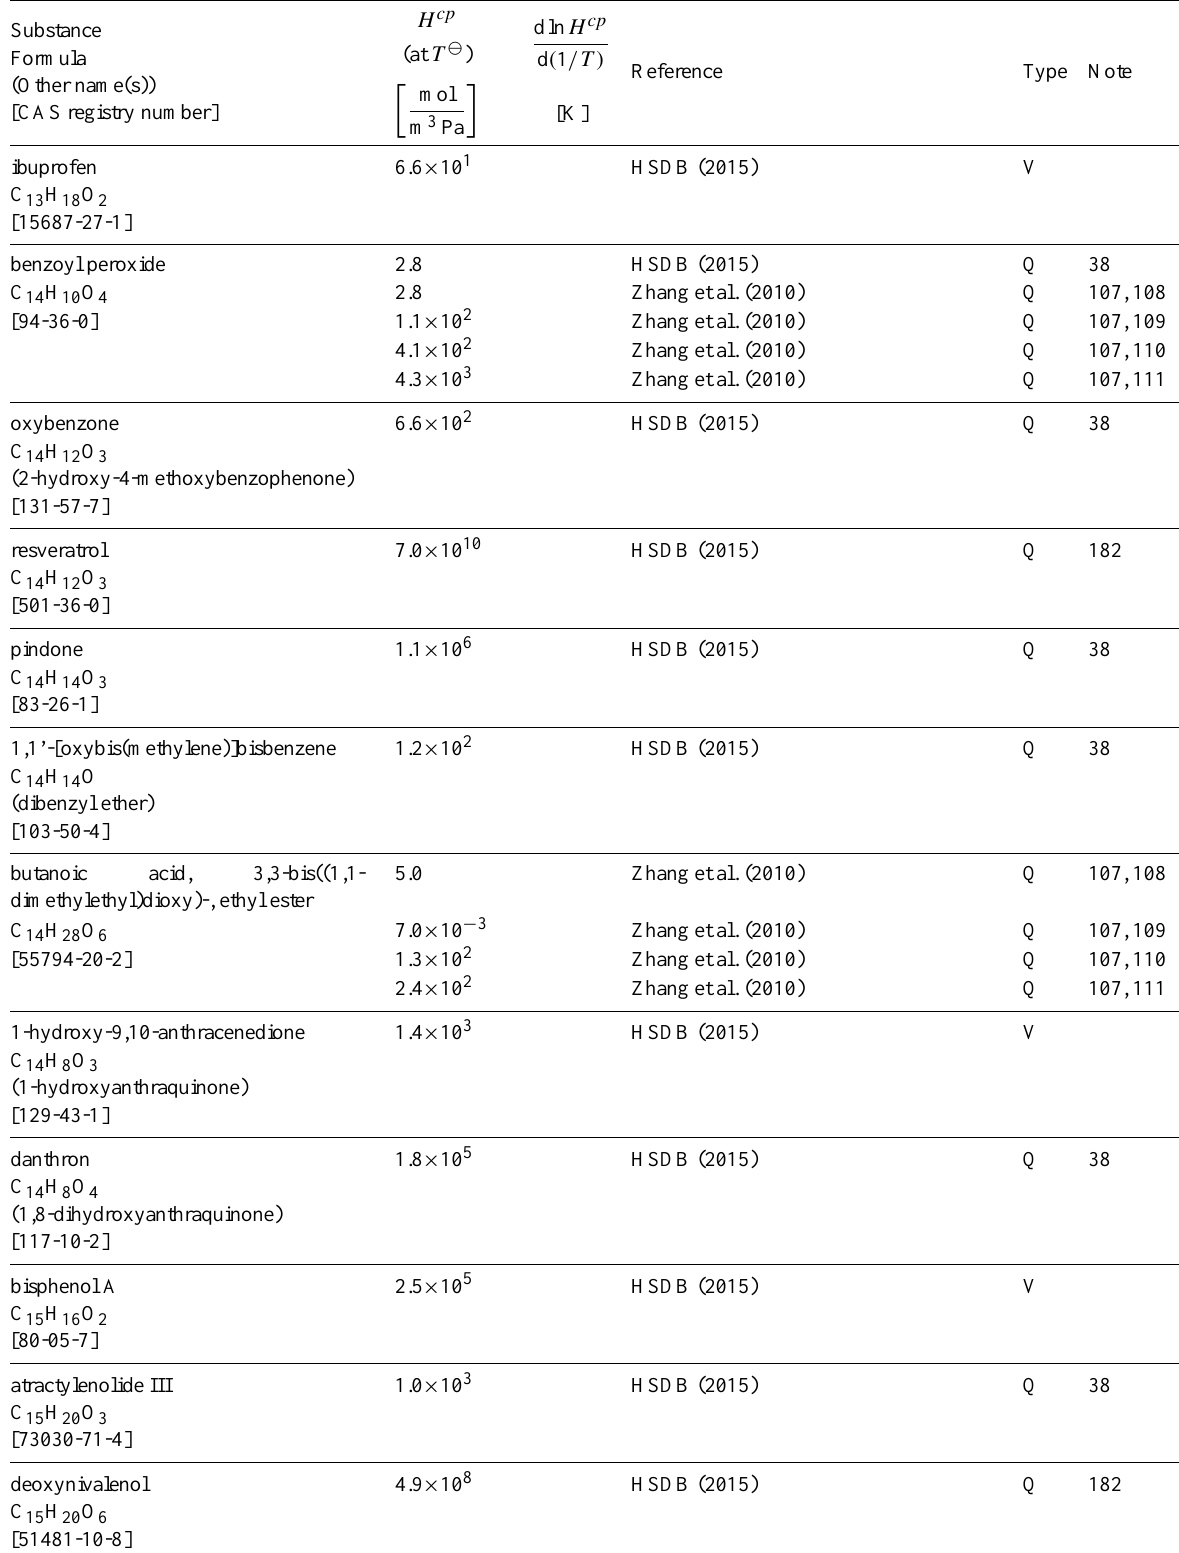
Table 6: Henry’s law constants for water as solvent